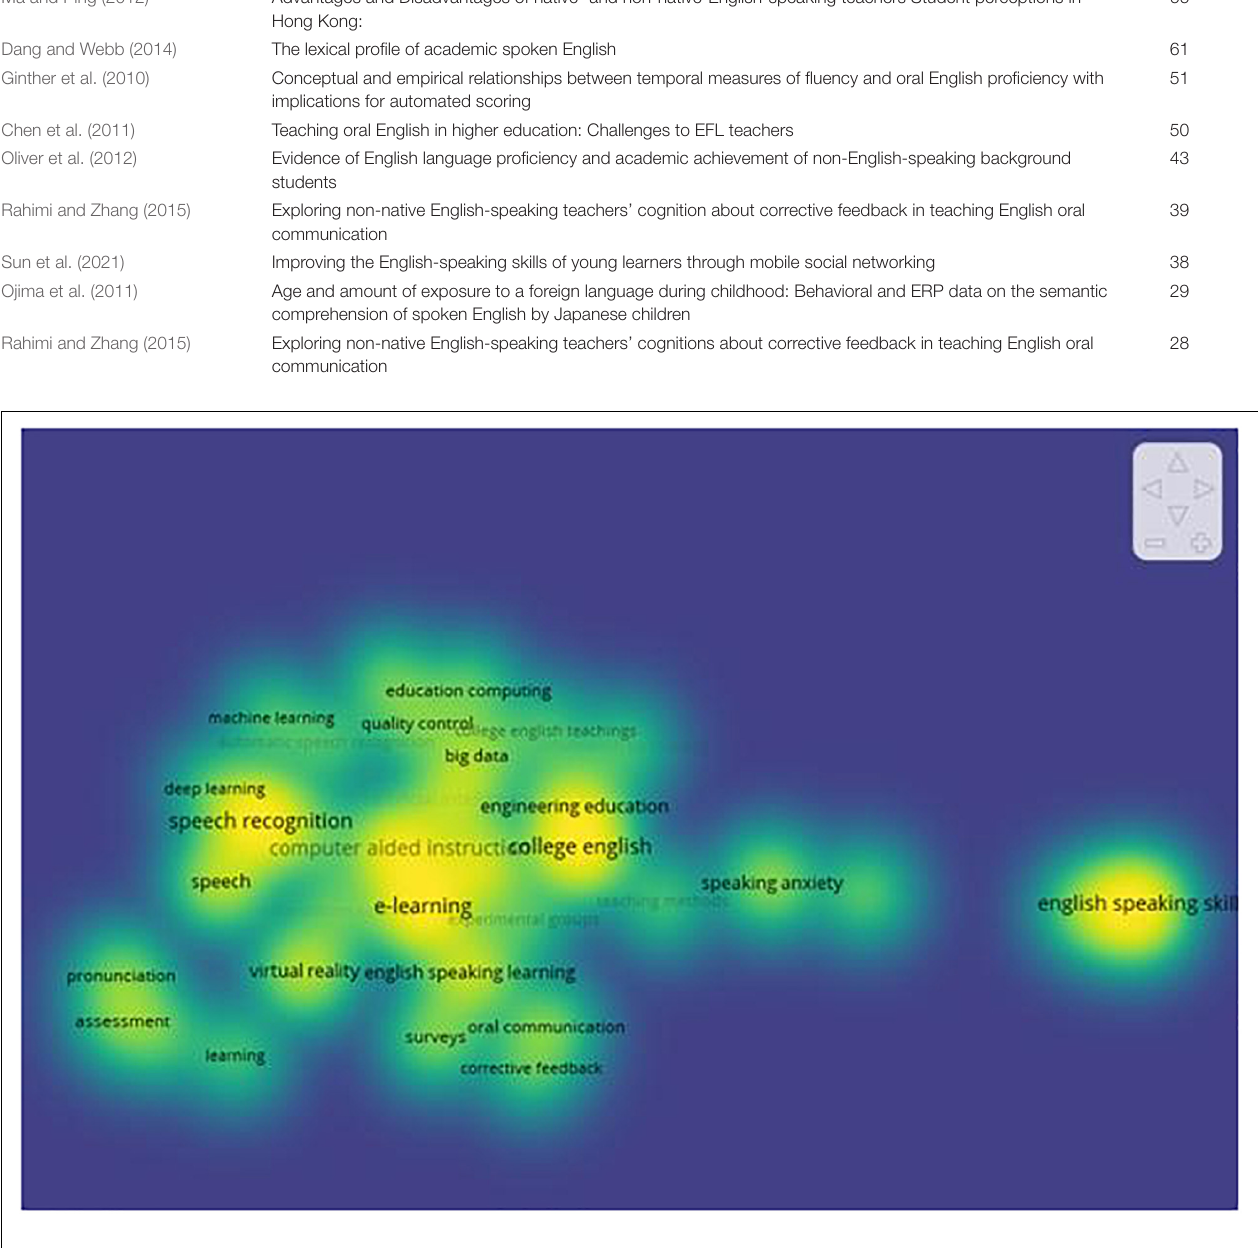
FIGURE 6 | Density map of the key